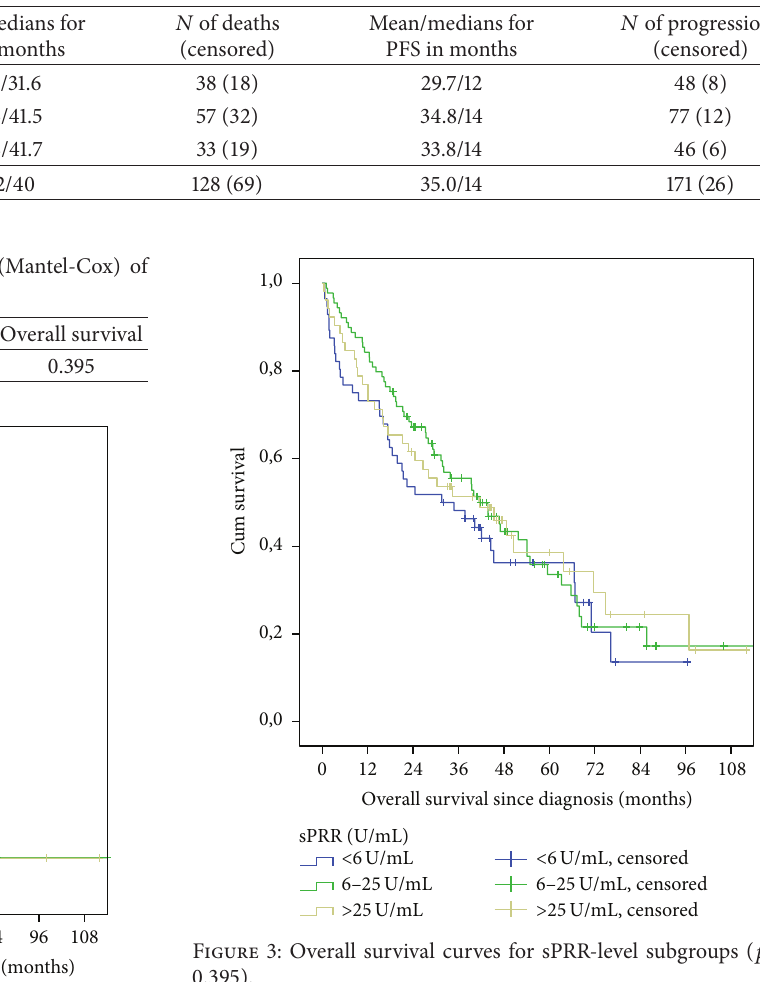
Table 4: Mean and median for overall survival (OS) and progression-free survival (PFS) in sPRR groups.